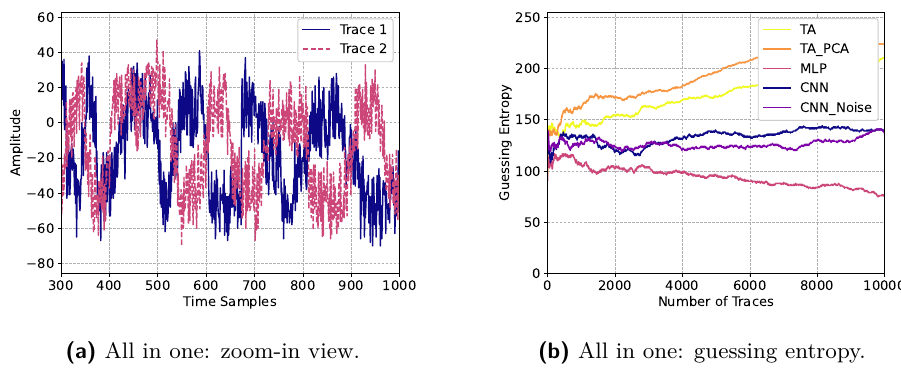
Figure 18: All in one (fixed key): demonstration and its influence on guessing entropy.